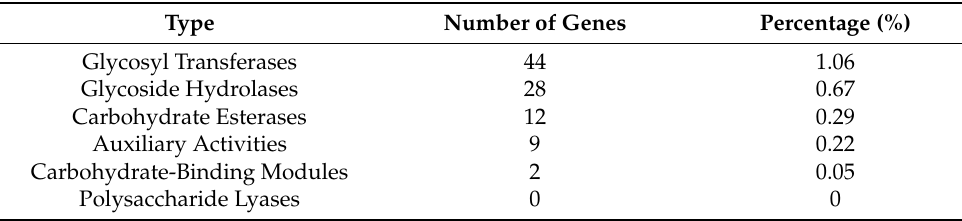
Table 2. CAZy analysis statistics.